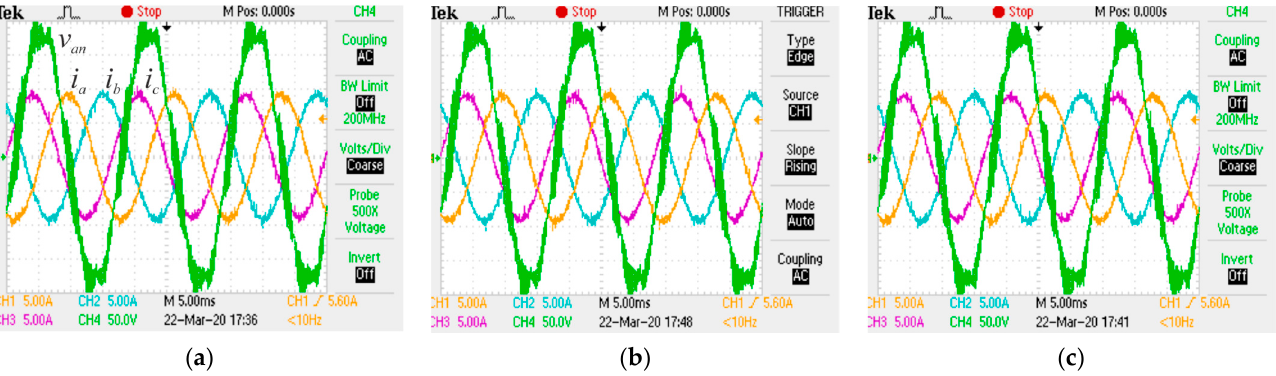
Figure 10. Steady ‐ state analysis of multi ‐ resonant control under distorted voltage. ( a ) abc–PR fund. +5th +7th, ( b ) αβ –PR fund. +5th +7th and ( c ) dq–PI + 6th resonant.